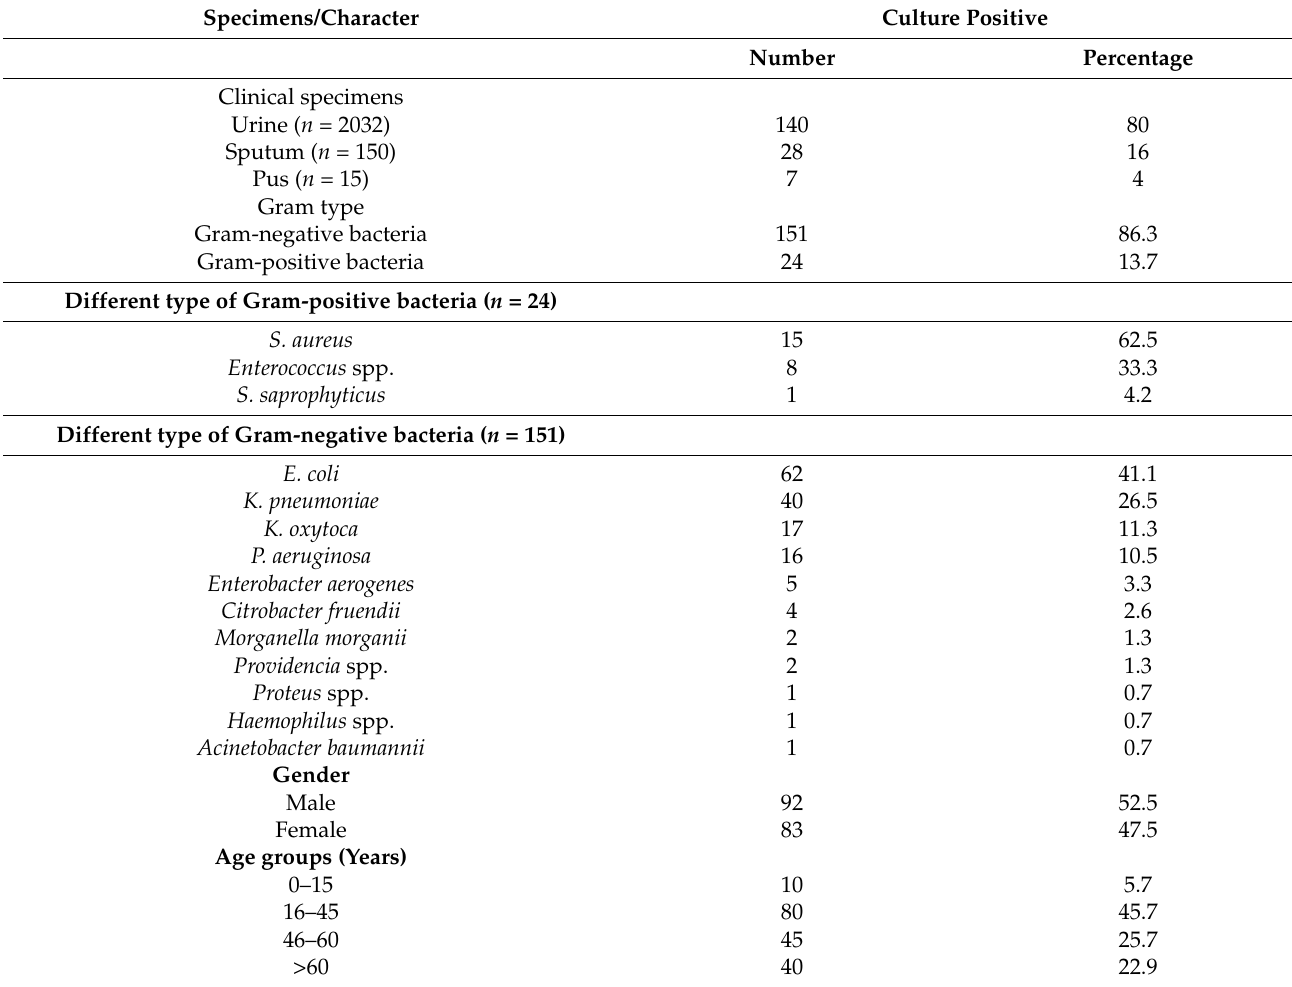
Table 1. Distribution of growth pattern of bacterial isolates ( n = 175).